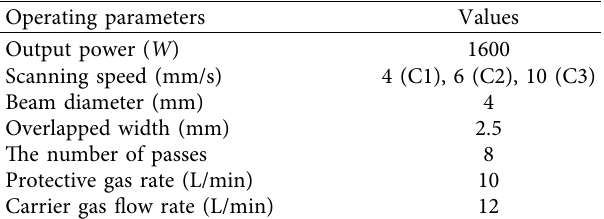
Table 1: Operating parameters of the laser cladding